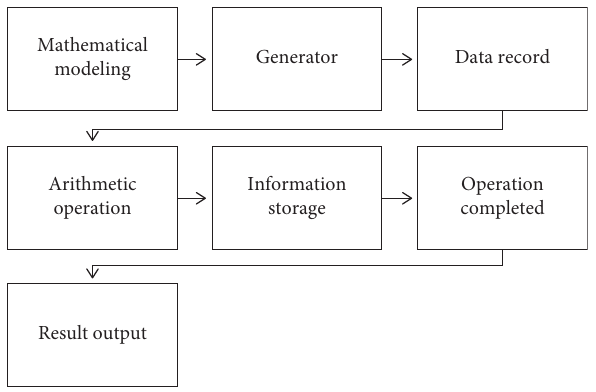
Figure 4: Typical info processing flow of computer